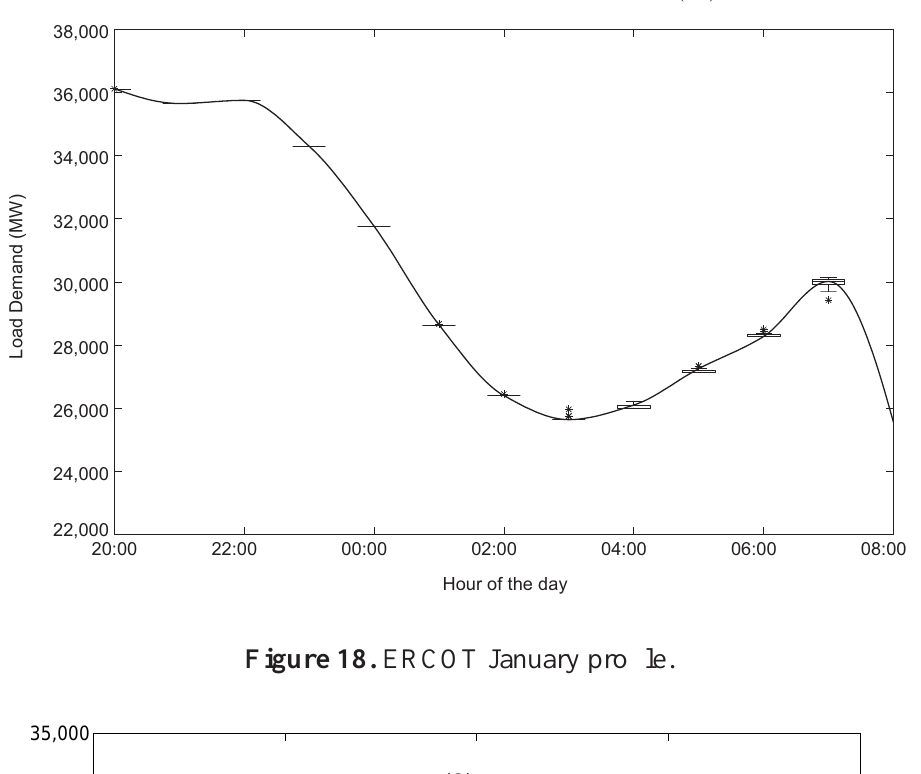
Figure 17. Data deviation in Algorithm ( C ) .